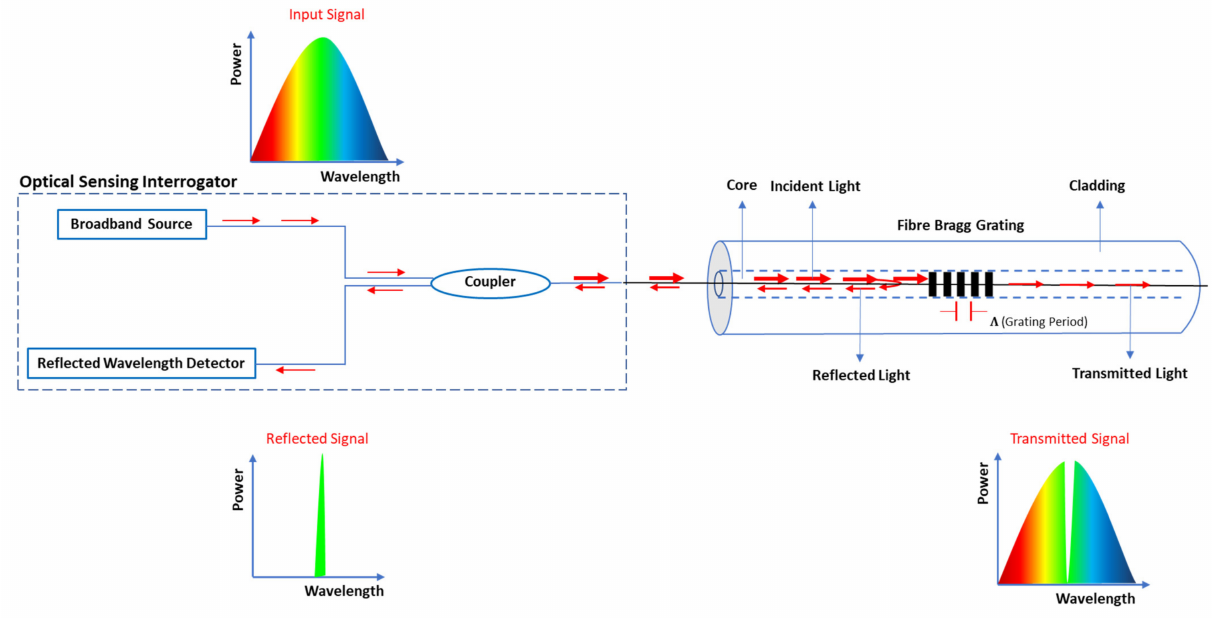
Figure 1. Structure of an optical fibre and scientific principle of FBG sensing